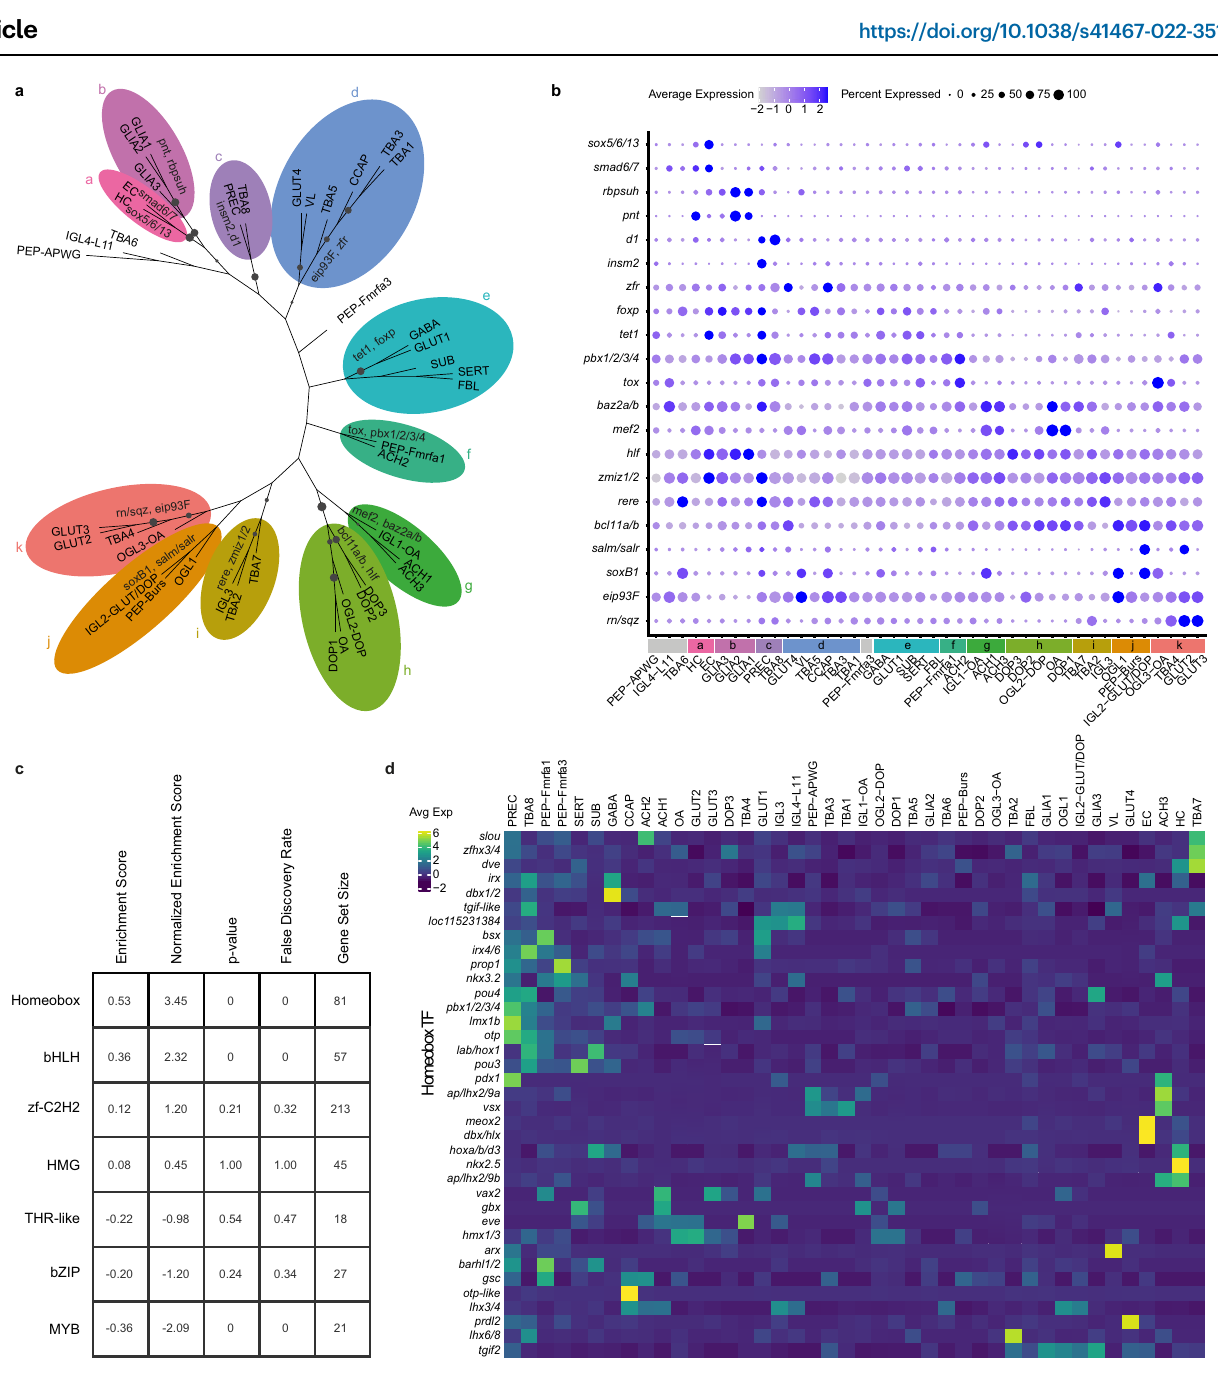
Fig. 6 | Cell-typespeci fi cityand transcription factors.a Neighbor-joining tree of octopus cell types. Branches with bootstrap supporthigher than0.5 are visualized by increasing dot size. Differentially expressed transcription factors (TFs) for each group are shown. b Differentially expressed TFs from a are shown in a dot plot.